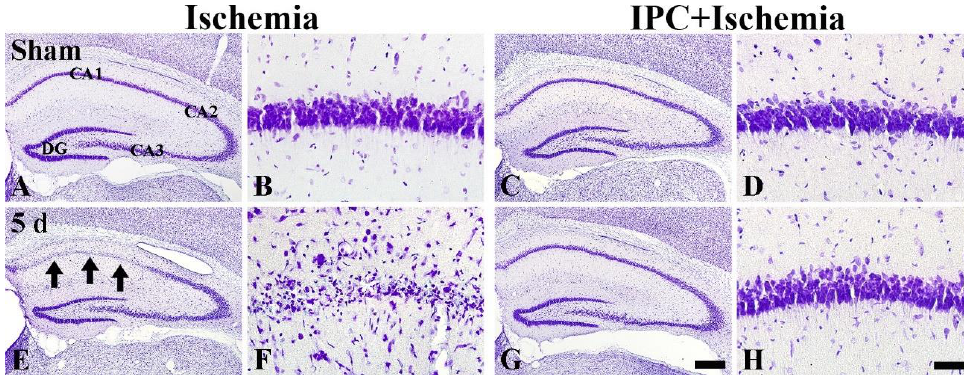
Figure 1. Cresyl Violet (CV) histochemistry in gerbil hippocampus of the sham ( A , B ), TI ( C , D ), IPC+sham ( E , F ), and IPC+TI ( G , H ) groups. Pyramidal cells are severely damaged (arrows in ( E , F )) in CA1, not CA2/3, at 5 days after TI. On the other hand, CA1 pyramidal neurons in the IPC+TI group ( G , H ) are similar to those shown in the sham group. Scale bar = 400 µm ( A , C , E , G ), and 50 µm ( B , D , F , H ).